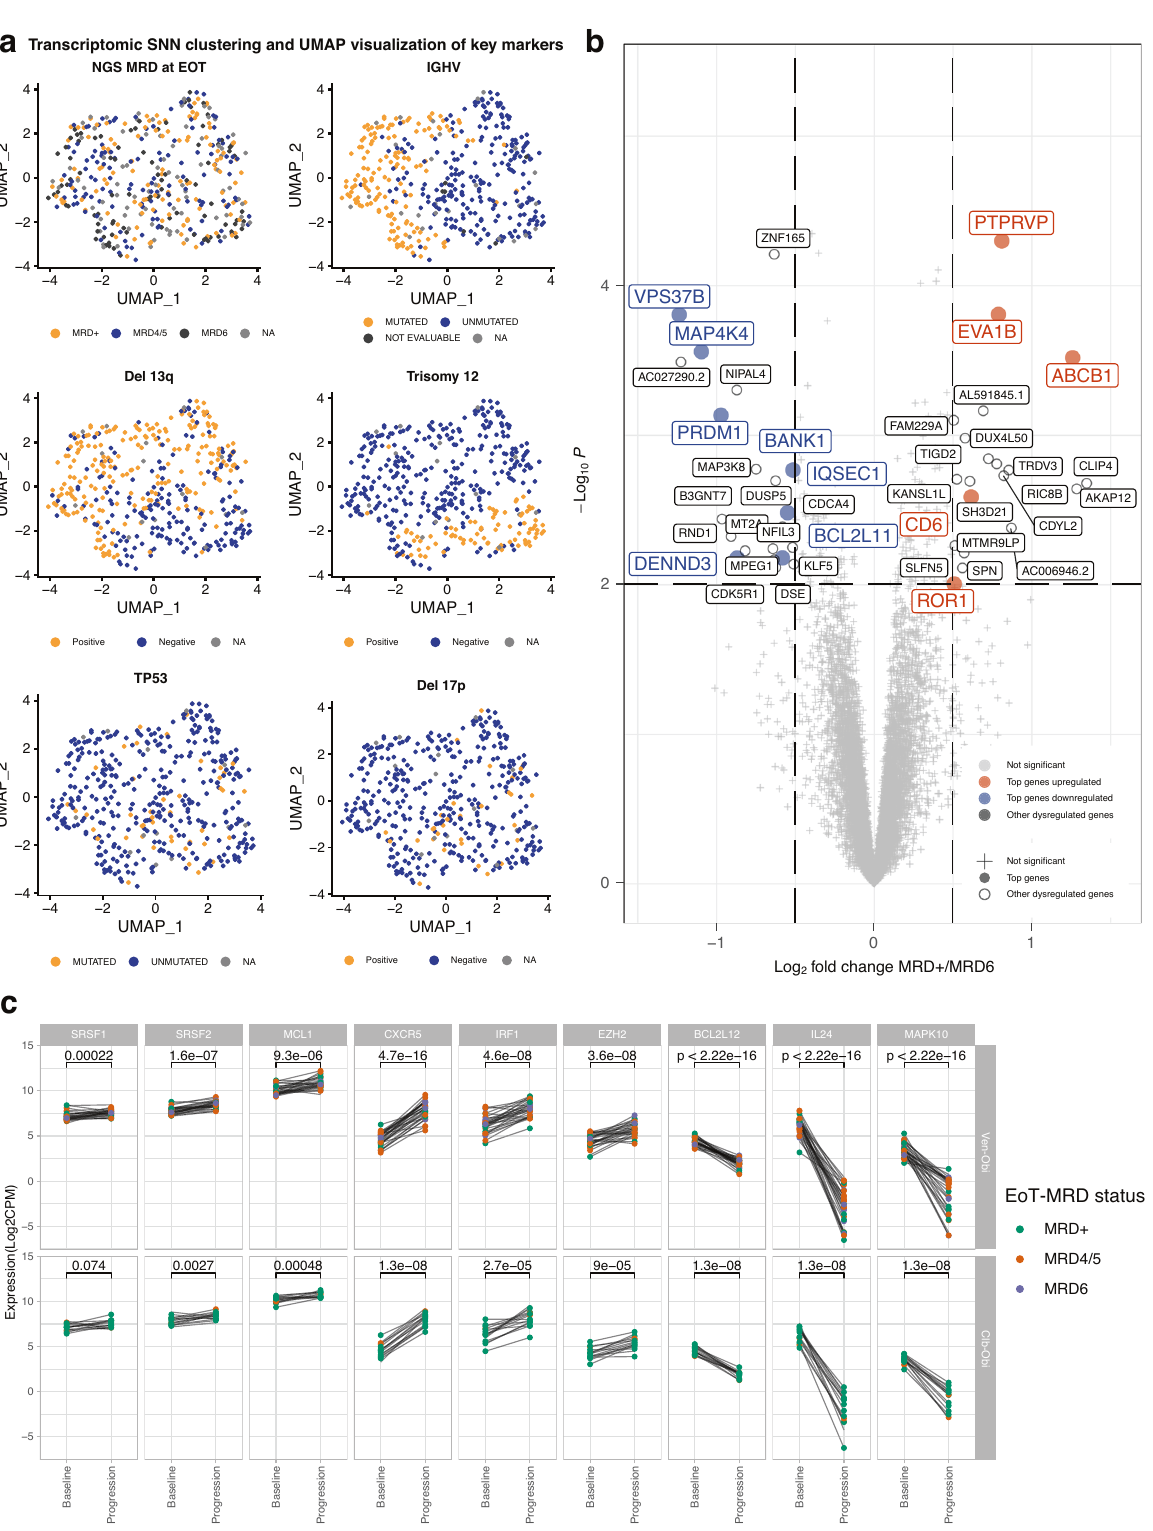
Fig. 3 | Differential gene expression according to minimal residual disease status and baseline versus relapse status. a UMAP (Uniform Manifold Approx- imationand Projection)visualizationofsharednearestneighbour(SNN)clustering before treatment, with MRD, IGHV, deletion 17p, TP53 , deletion 13q, and trisomy 12 status overlaid. b Pre-treatment differential gene expression between MRD6 vs MRD+, gene previously associated with CLL pathology are highlighted; dashed